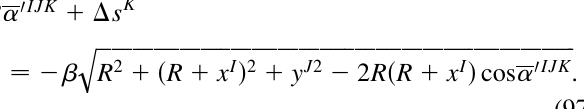
FIG. 13. Transverse positions of field point relative to source point, x calculated at the dot-dot grid intersections, which are half-period staggered relative to the source